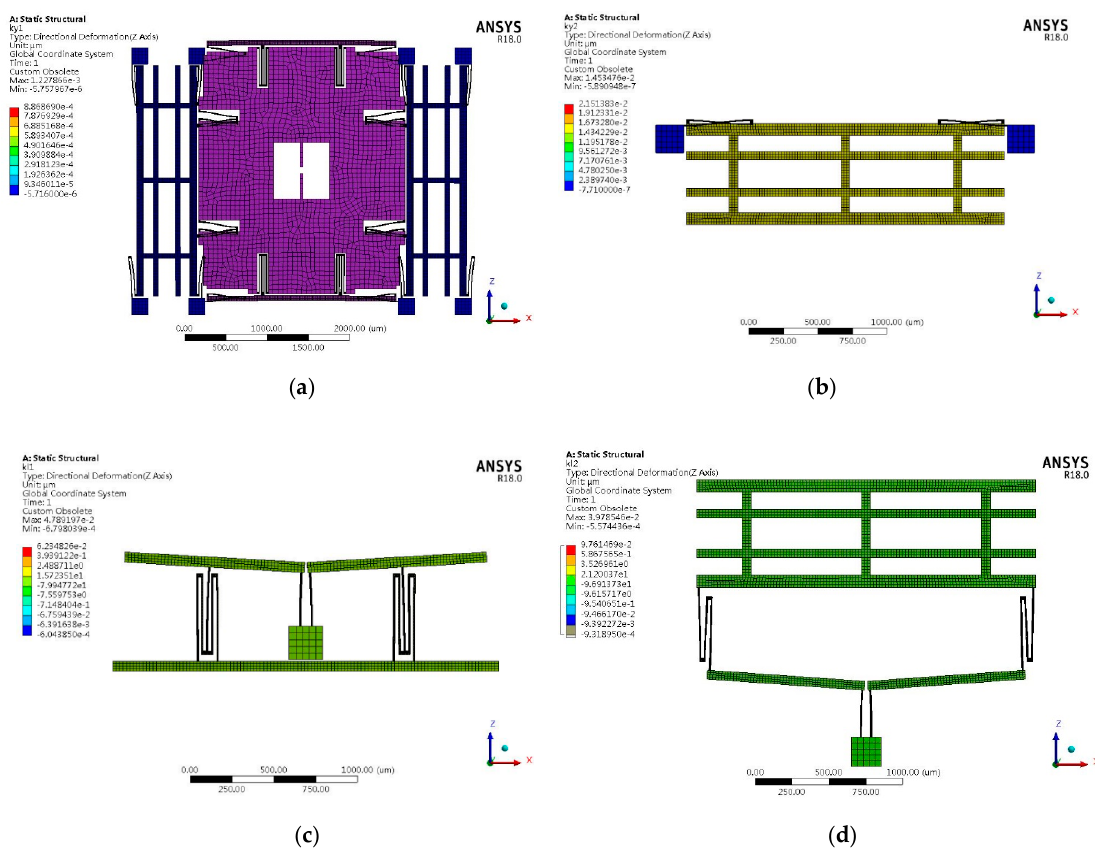
Figure 4. Stiffness of sense mode of micro-electro-mechanical (MEMS) gyroscope: ( a ) deformation of k y 1 ; ( b ) deformation of k y 2 ; ( c ) deformation of k l 1 ; ( d ) deformation of k l 2 .